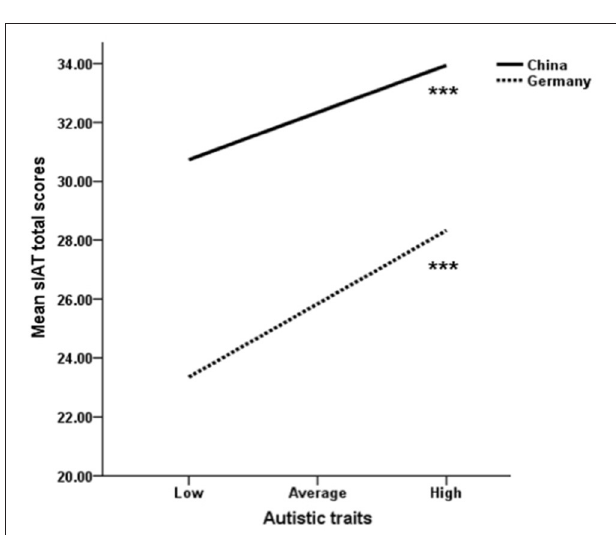
FIGURE 2 | Simple slopes to illustrate the interaction effect between autistic traits and country on the s-IAT total scores. Note: *** indicates that the s-IAT change from low to high autistic traits was significant ( p <